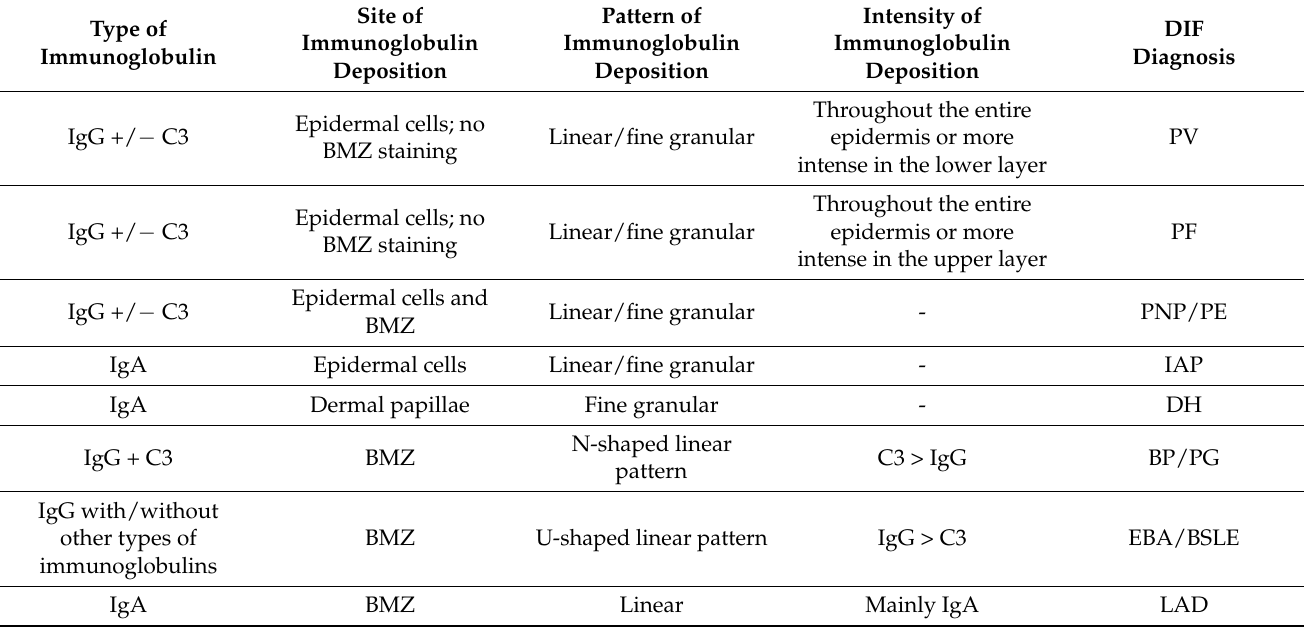
Table 2. Criteria For the Direct Immunofluorescence Stain Diagnosis of Autoimmune Bullous